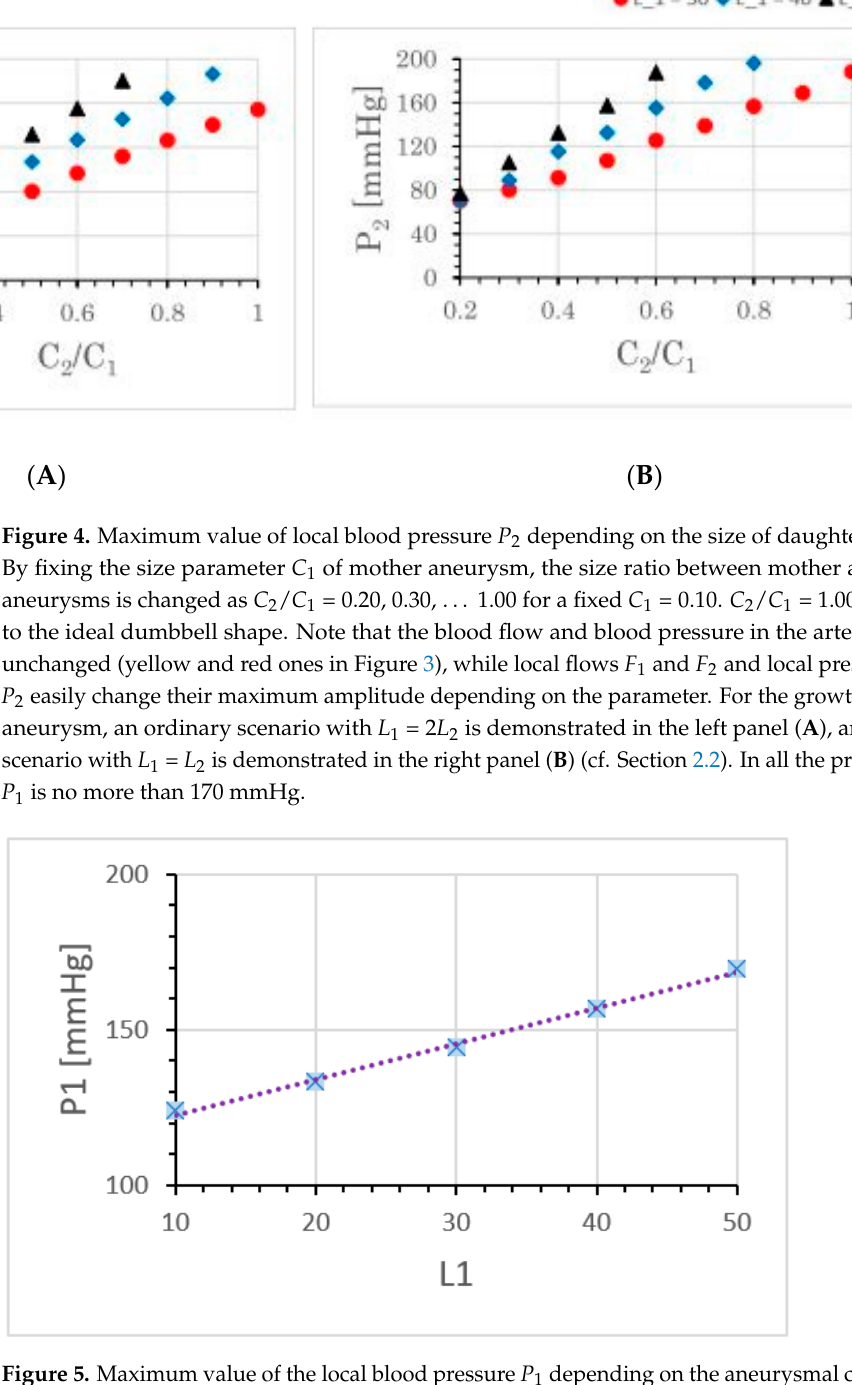
Figure 5. Maximum value of the local blood pressure P 1 depending on the aneurysmal compliance L 1 . The daughter aneurysms are not assumed to be formed well ( C 2 = 0.1, C 2 = 0.001, L 2 = 0). By changing the compliance parameter L 1 of mother aneurysm, the local pressure P 1 of mother aneu- rysm increases linearly. Note that the blood flow F – F 1 and blood pressure P in the parent artery is nothing different from those given by Figure 3.